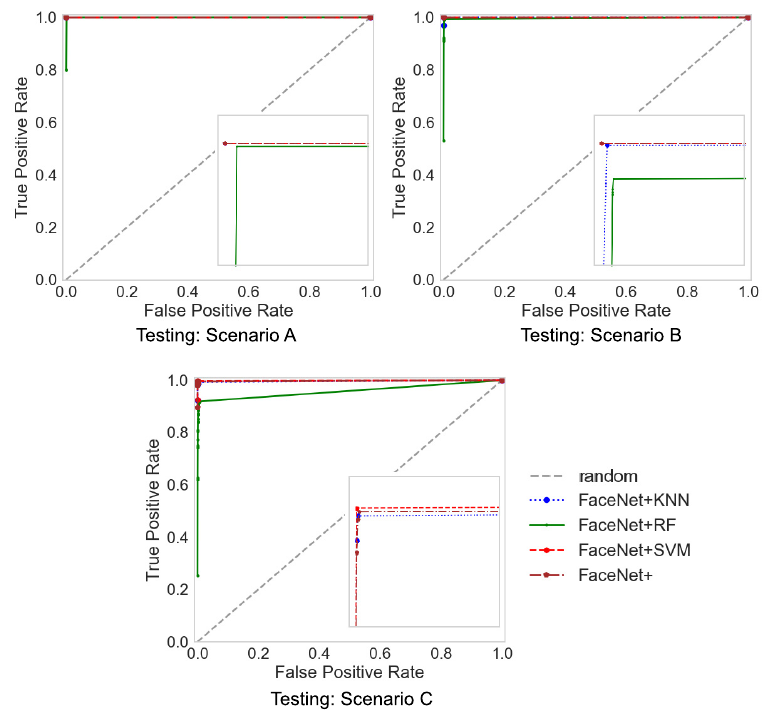
Figure 9. ROC curves in different scenarios of our proposed